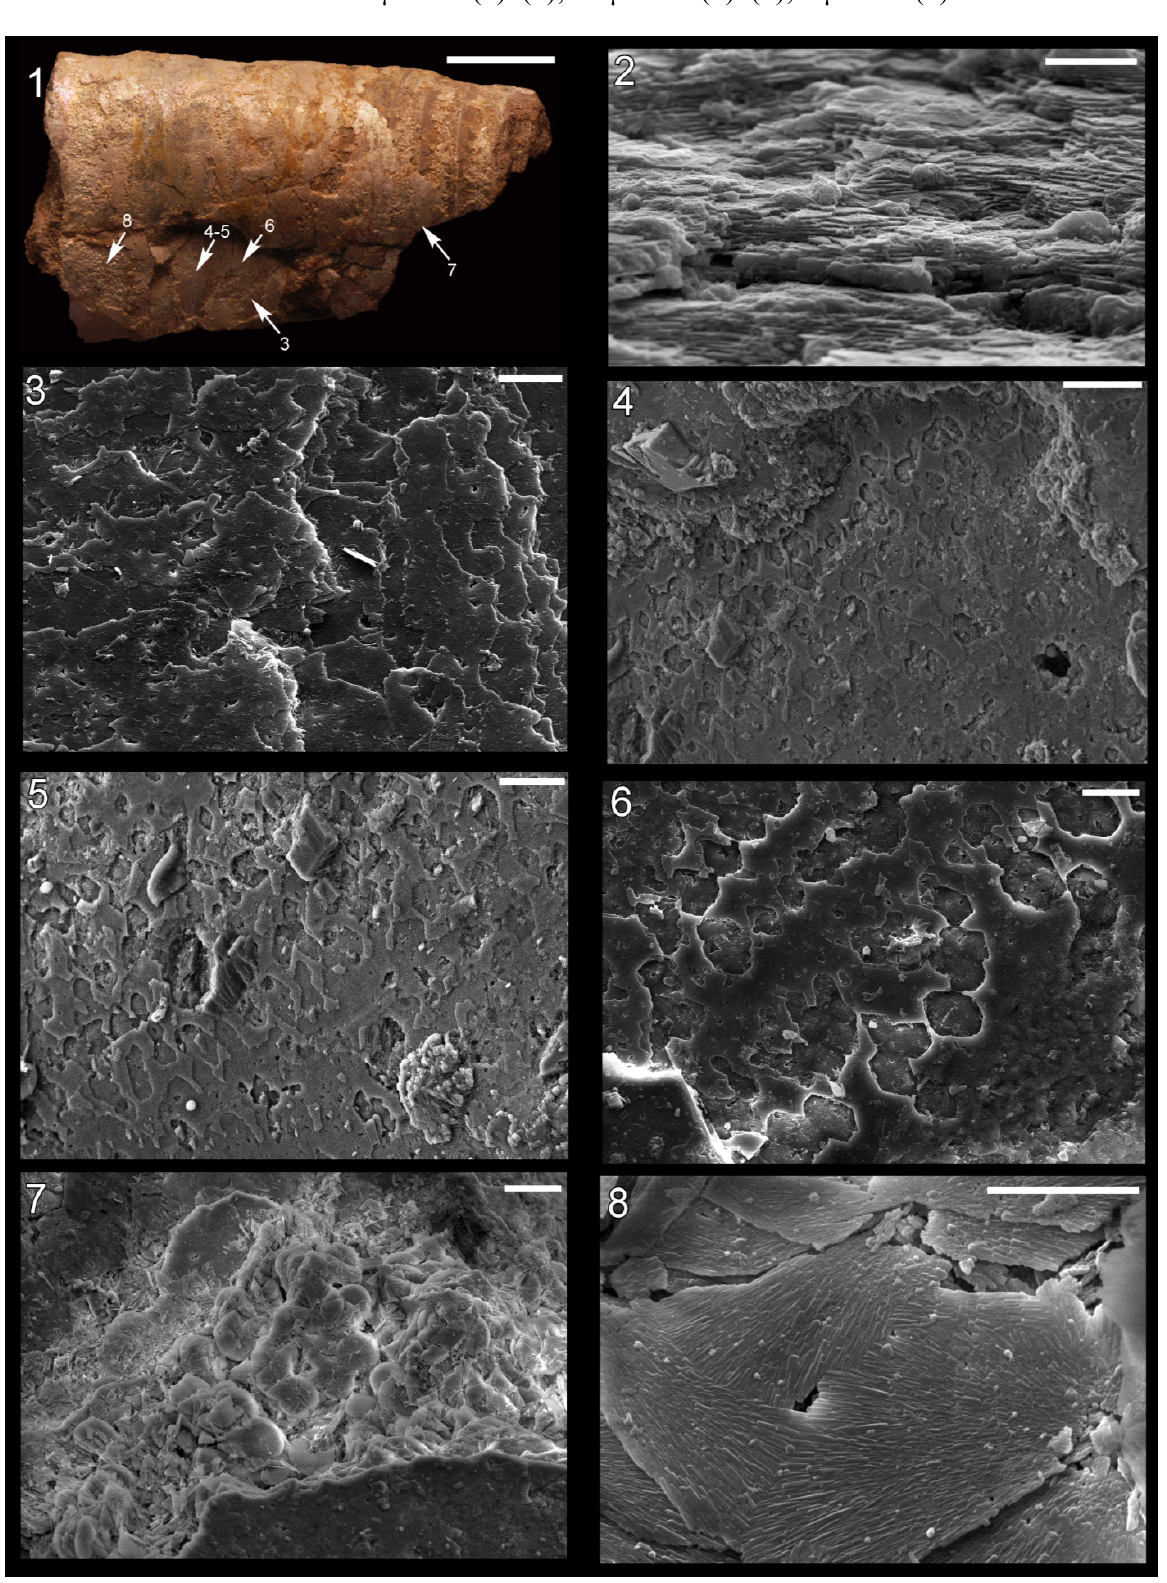
Figure 2. Shell microstructure in specimens of Isorthoceras from the Ordovician Maquoketa Formation. ( 1 ), ( 3 )–( 8 ) LACMIP 14434, arrows in ( 1 ) show locations of images in ( 3 )–( 8 ); ( 2 ) LACMIP 14435, view of semi-horizontal section of inner shell layer, top of photo is more internal. Scale bars: 10 µm for ( 1 )–( 3 ); 20 µm for ( 4 )–( 7 ); 5 µm for ( 8